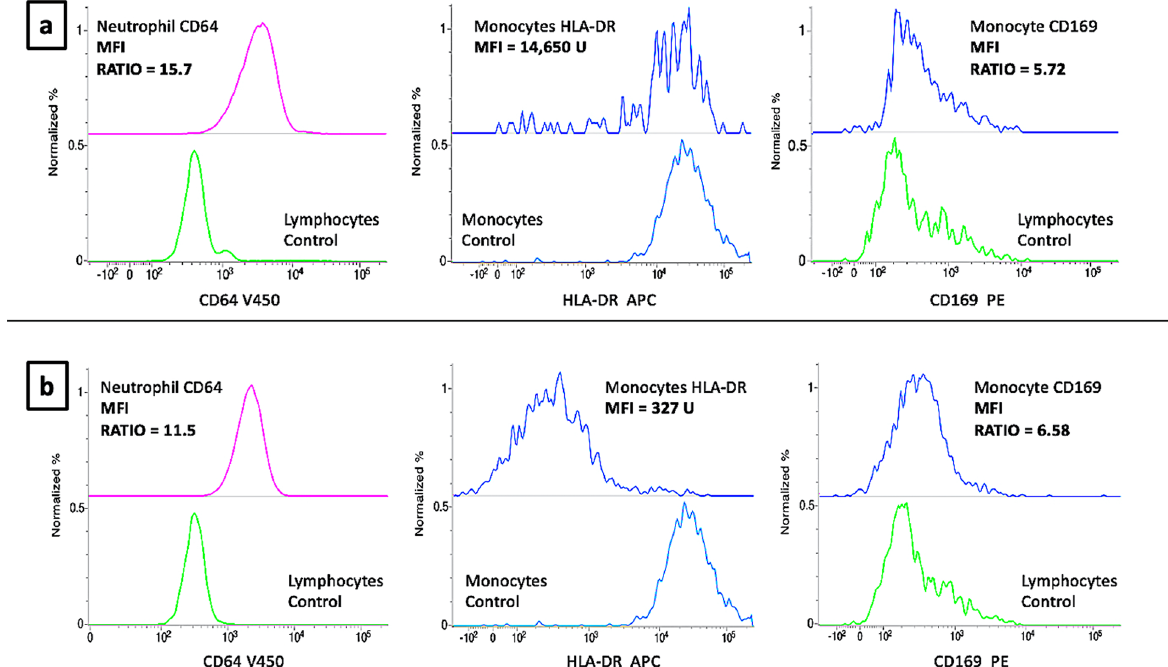
Fig. 5 Examples of some of the many possible findings in the monitoring of SARS-CoV2-infected patients undergoing sepsis during their clinical follow-up. Upper row ( a ): Moderate neCD64 upregulation, normal moHLA-DR expression, and cleared SARS-CoV2, with normal moCD169